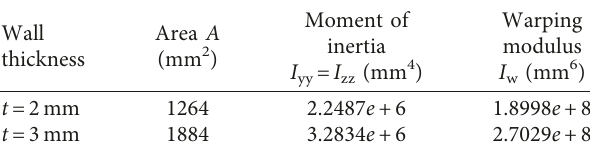
Table 1: Mechanical properties of the cross sections.